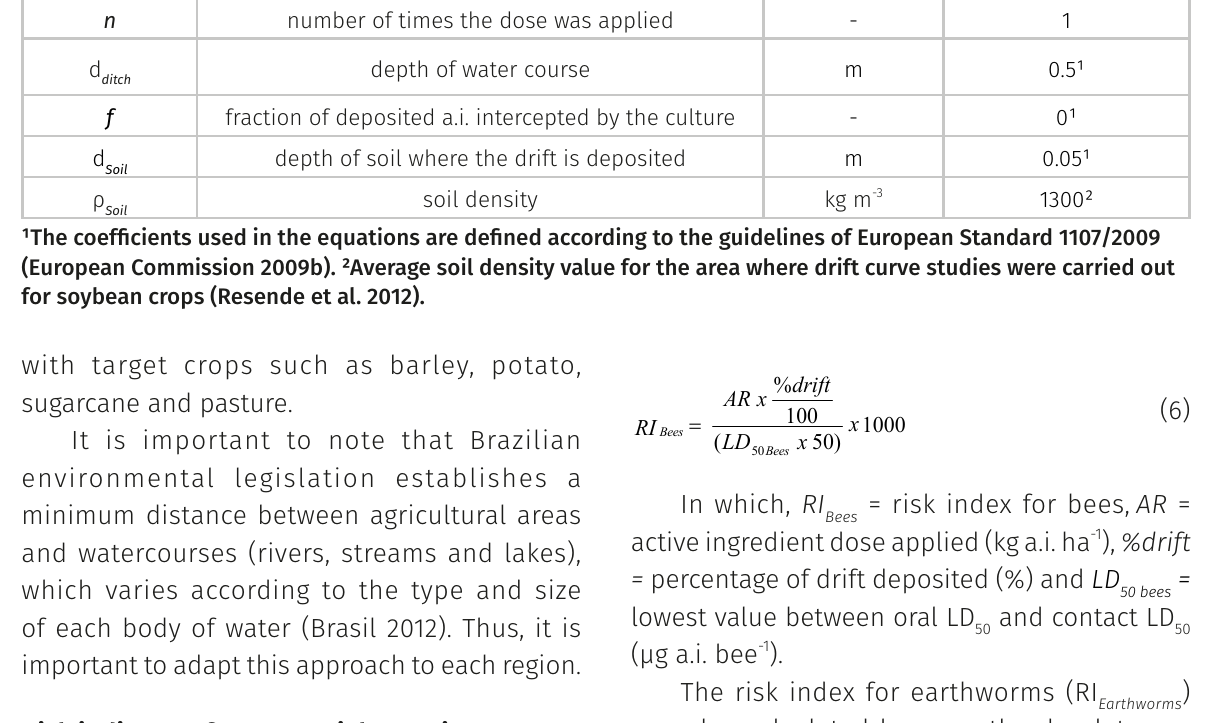
Table VI. Descriptions and values used to calculate the risk indices for aquatic (fish, daphnia and algae) and terrestrial (bees and earthworms) organisms. Parameter Description Units Value used in the study n number of times the dose was applied - 1 depth of water course m 0.5¹ d ditch f fraction of deposited a.i. intercepted by the culture - 0¹ depth of soil where the drift is deposited m 0.05¹ d Soil soil density kg m -3 1300² ρ Soil ¹The coefficients used in the equations are defined according to the guidelines of European Standard 1107/2009 (European Commission 2009b). ²Average soil density value for the area where drift curve studies were carried out for soybean crops (Resende et al.